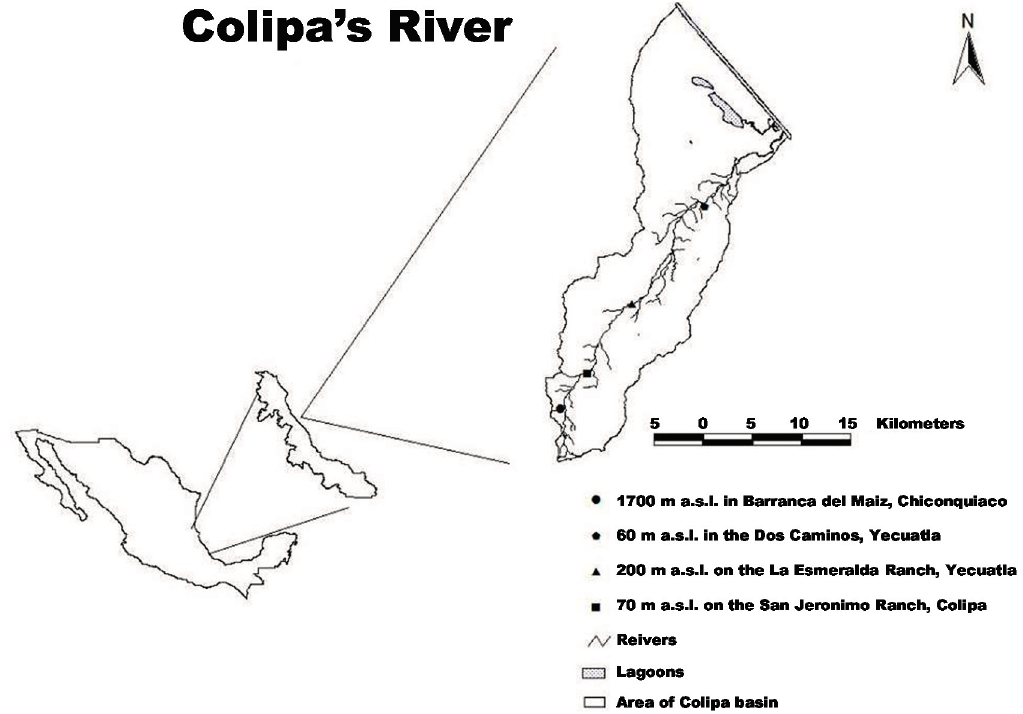
Figure 3. Location of four sampled sites of P. mexicana in the Colipa